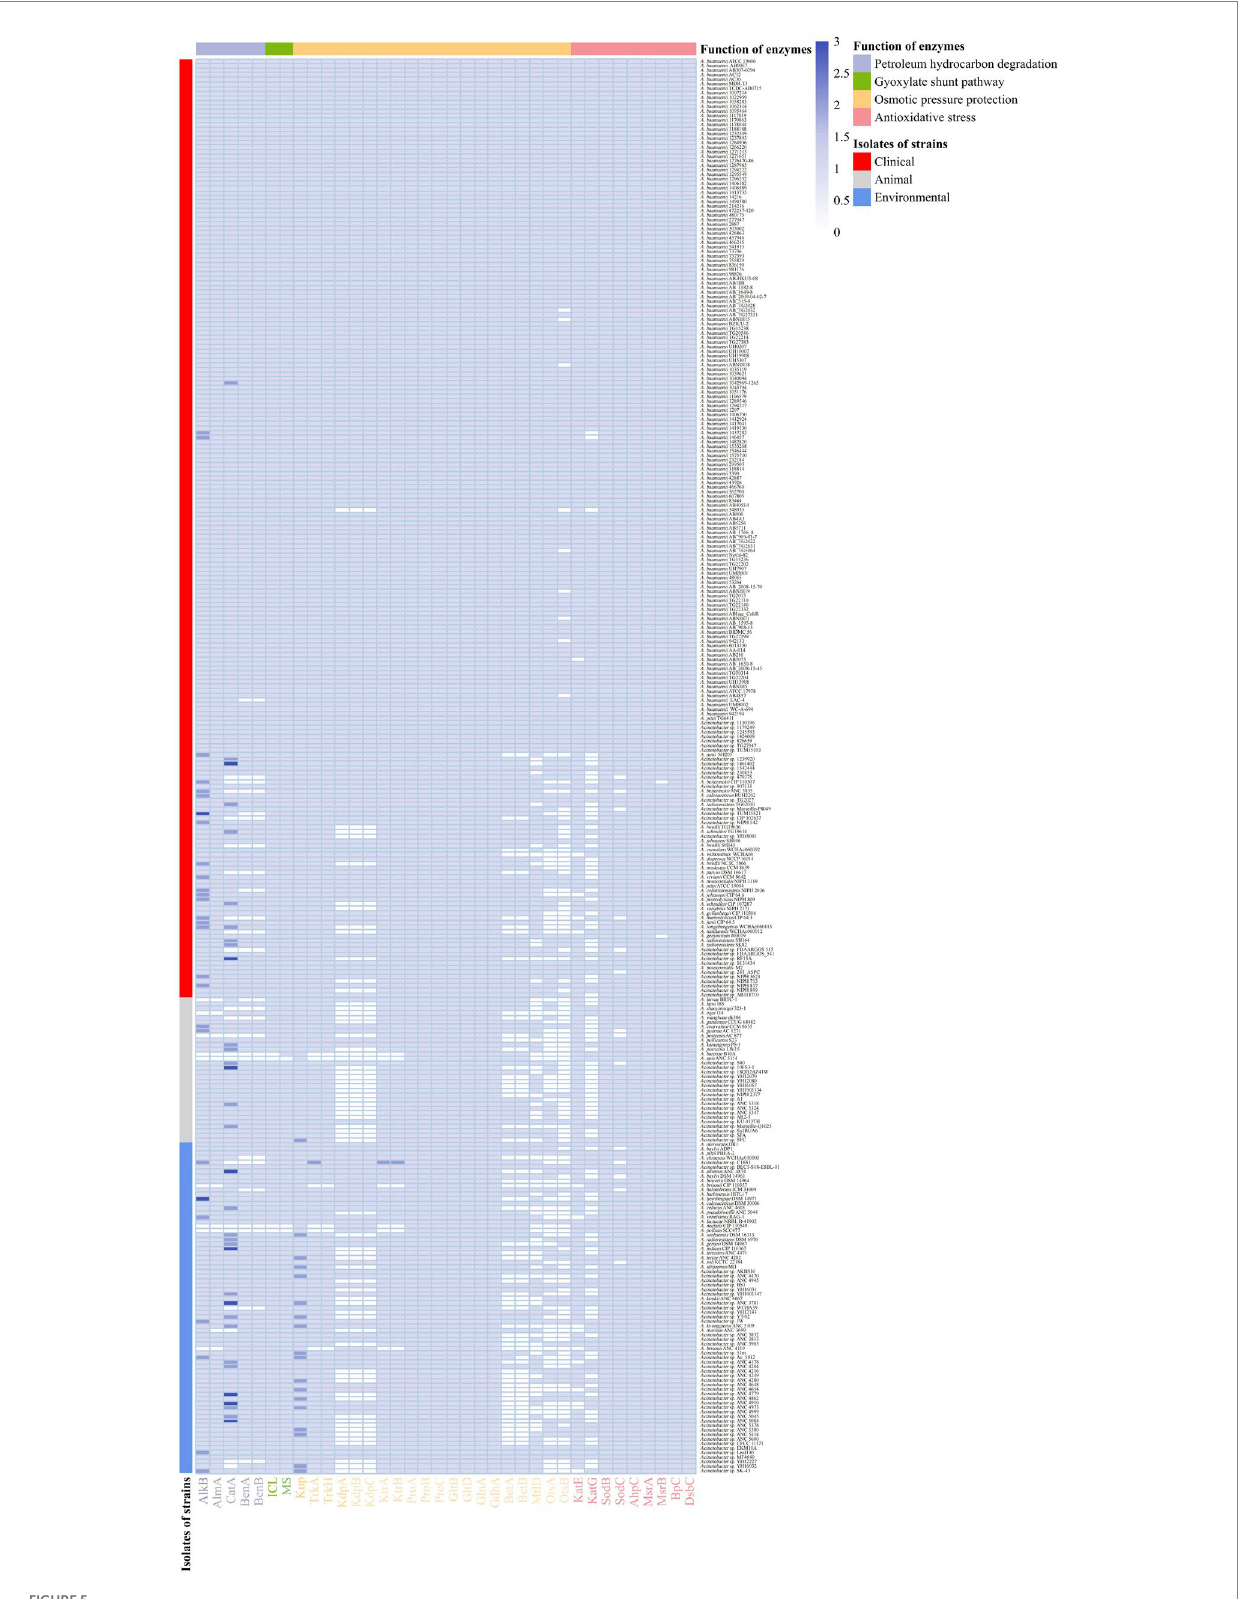
FIGURE 5 Distribution of enzymes with functions of petroleum hydrocarbon degradation, osmotic pressure protection and anti-oxidative stress in 312 strains. Petroleum hydrocarbon degrading enzymes, AlkM, AlmA, CatA, BenA, BenB; Glyoxylate shunt pathway enzymes, ICL, MS; Potassium ion transporters, Kup, TrkA, TrkH, KdpA, KdpB, KdpC KtrA, KtrB; Compatible solute synthases, ProA, ProB, ProC, GltB, GltD, GlnA, GdhA, BetA, BetB, MtlD, OtsA, OtsB; Antioxidant stress kinases, KatE, KatG, SodB, SodC, AhpC, MsrA, MsrB, BpC,